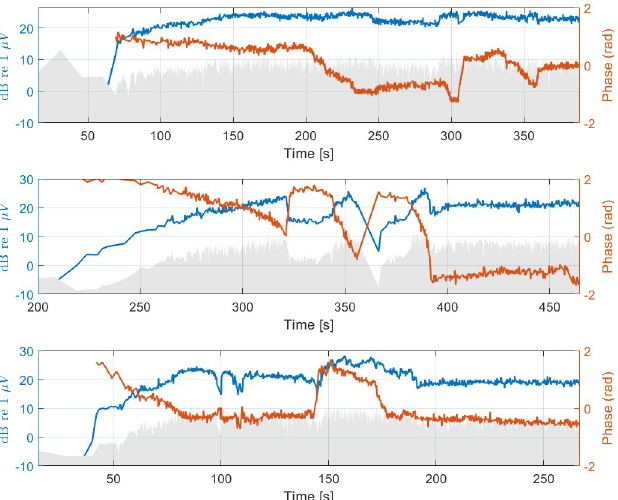
Fig 7. Cochlear Microphonic amplitude (blue) and phase (red) over insertion time. The top panel shows a Type I example where the amplitude does not drop by more than 5 dB. In the middle panel (Type II) each drop is accompanied by large phase changes. The insertion in the lower panel is classified as Type III because the two drops around an insertion time of 100 s don’t come with significant phase